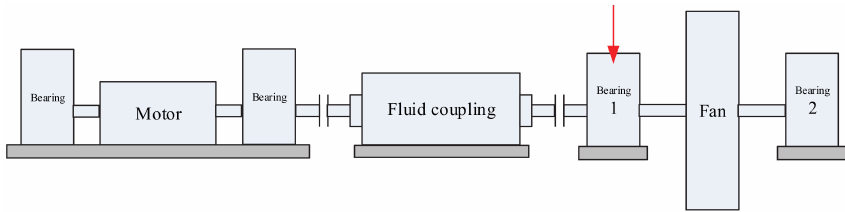
Figure 13. Schematic diagram of the large desulfurization fan structure.